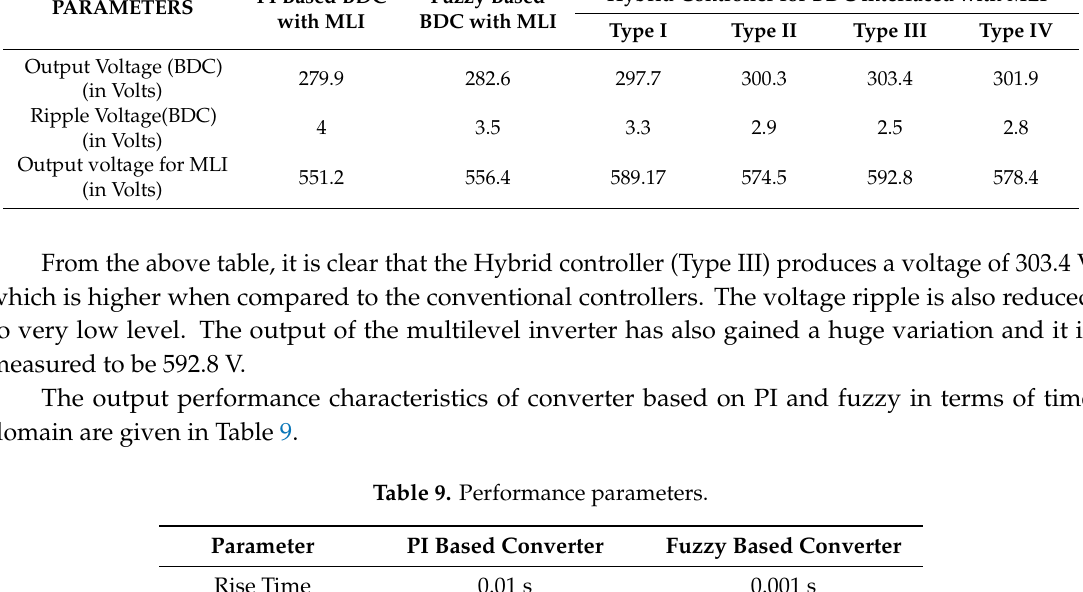
Figure 54. Output voltage waveform for multilevel inverter interfaced with hybrid Figure 54. Outputvoltagewaveformformultilevelinverterinterfacedwithhybridcontroller-4-basedBDC. controller-4-based BDC.